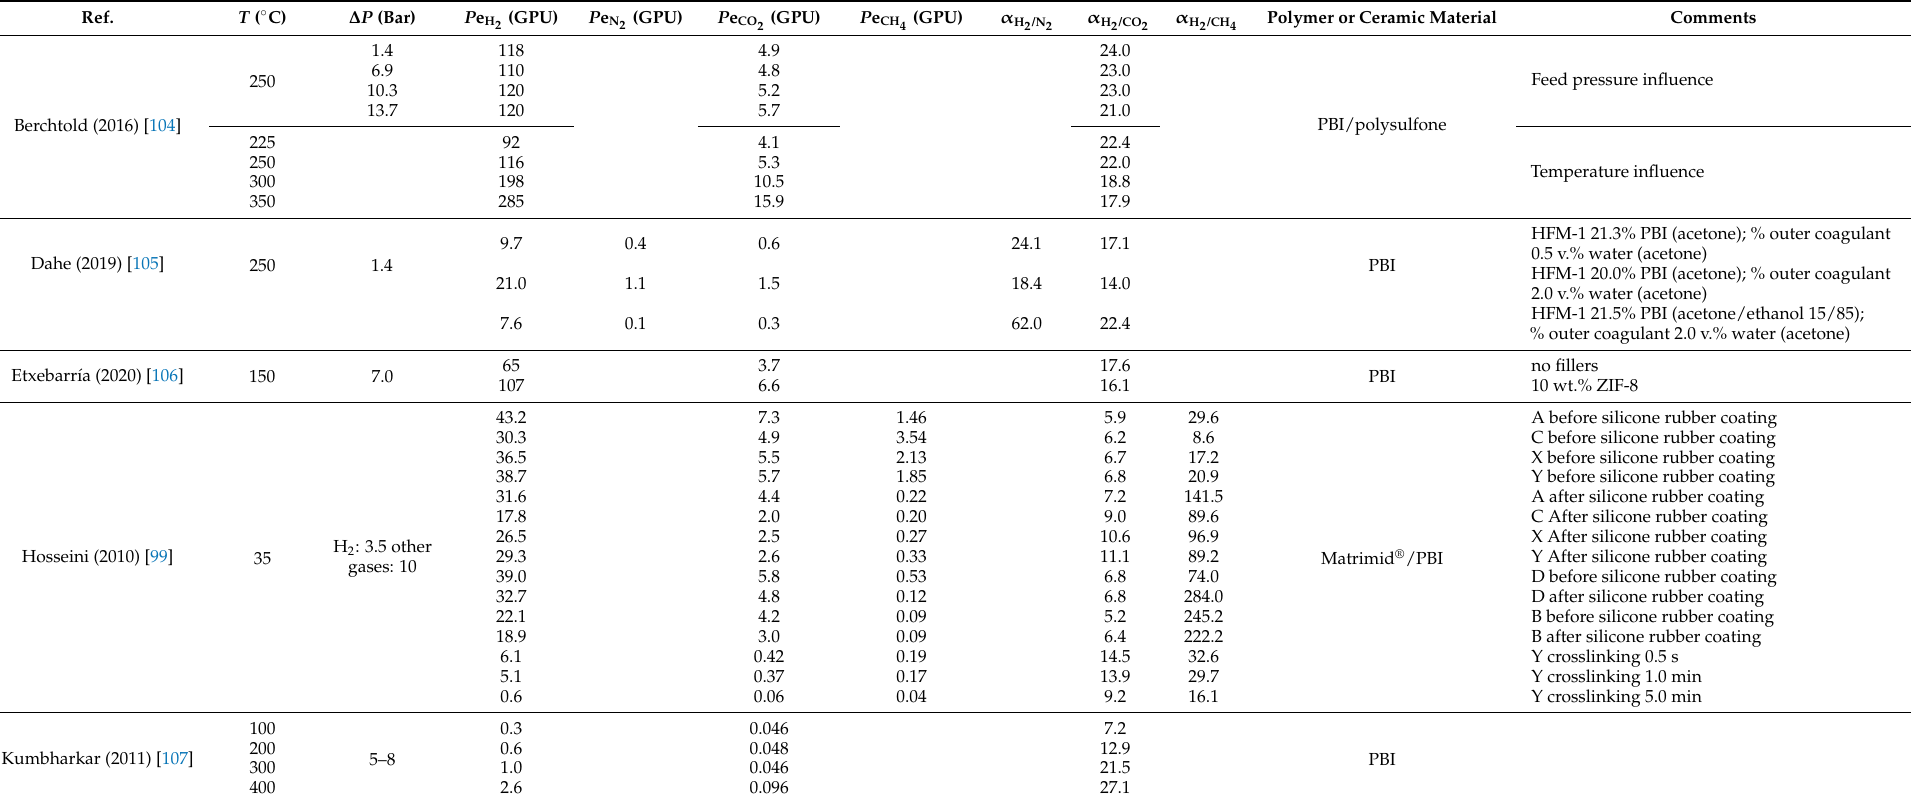
Table 6. Main bibliographical data in terms of pure gas H 2 , N 2 , CO 2 and CH 4 permeance (Pe) and selectivities through modified Matrimid ® HFMs in which polymer has been substituted or blended, the HFM has been chemically modified and/or the filler has been substituted or functionalized.